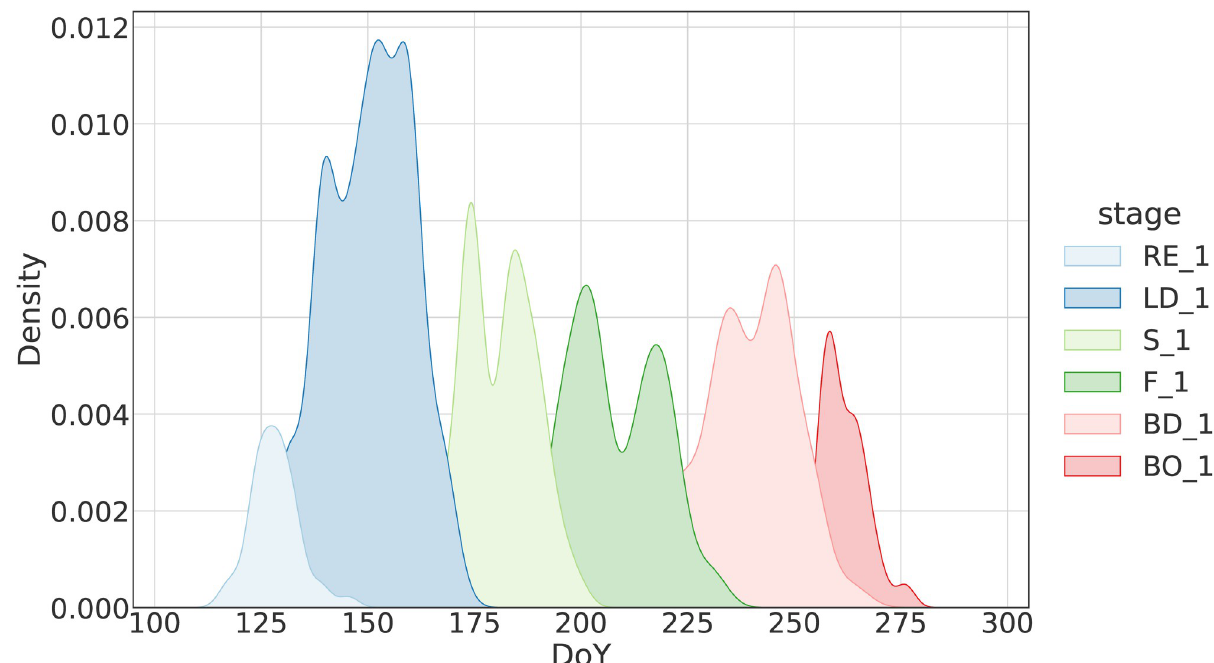
Fig 3. Distribution of DoY for which the inspector observed the phenological stages as primary.